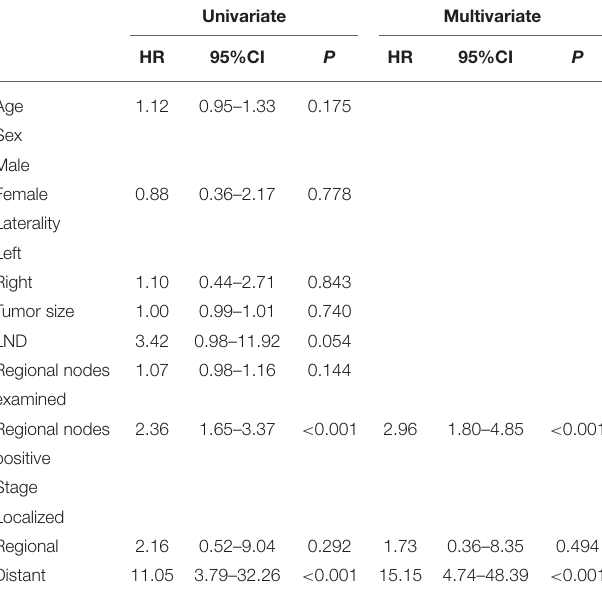
TABLE 4 | Univariate and multivariate analyses of CSS in CHCMU cohort. TABLE 3 | Univariate and multivariate analyses of CSS in SEER cohort. Univariate Multivariate Univariate